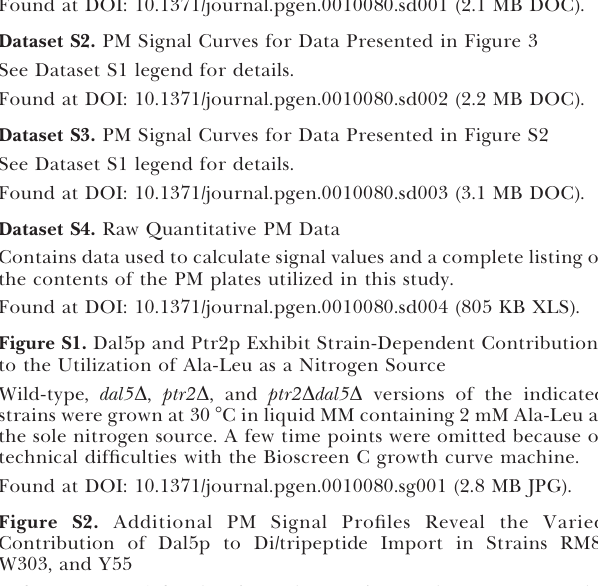
Table S1. Polymorphisms in the Region Upstream of PTR2, Relative to the Standard S288c Sequence Table S2. Oligos Used in This